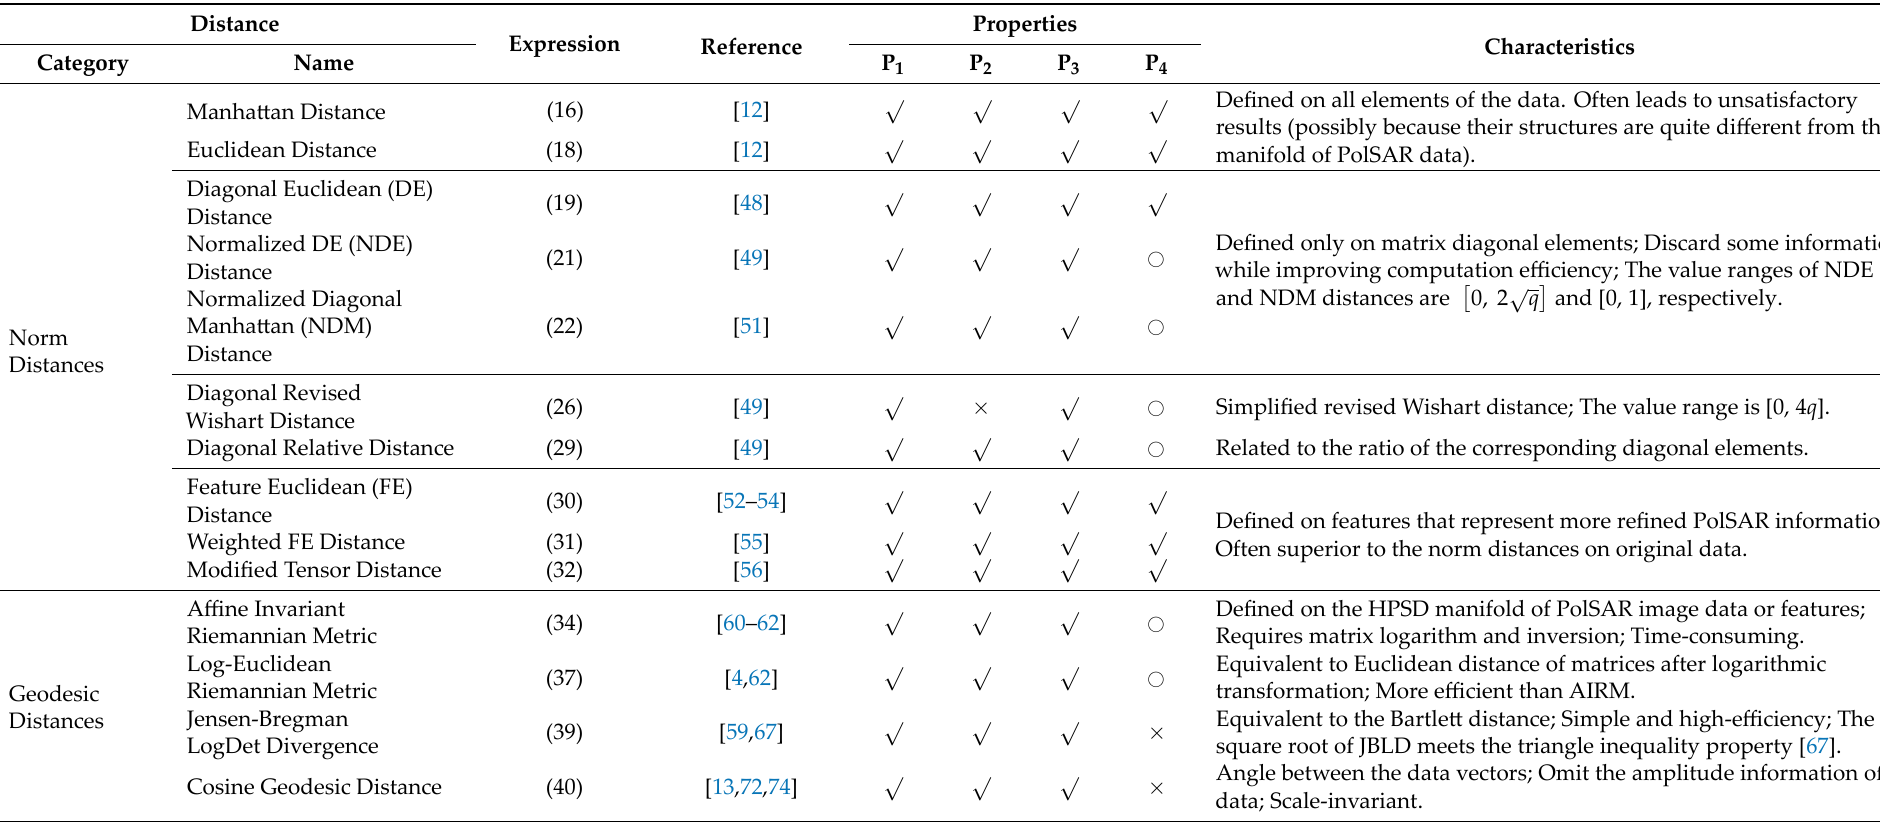
Table 7. Properties (P 1 : Non‑negativity, P 2 : Identity, P 3 : Symmetry, P 4 : Triangle inequality) and characteristics of some main distance measures of PolSAR image √ data. Notations “ ”, “ × ”, and “ # ” denote “Yes”, “No”, and “Unknown”, respectively.